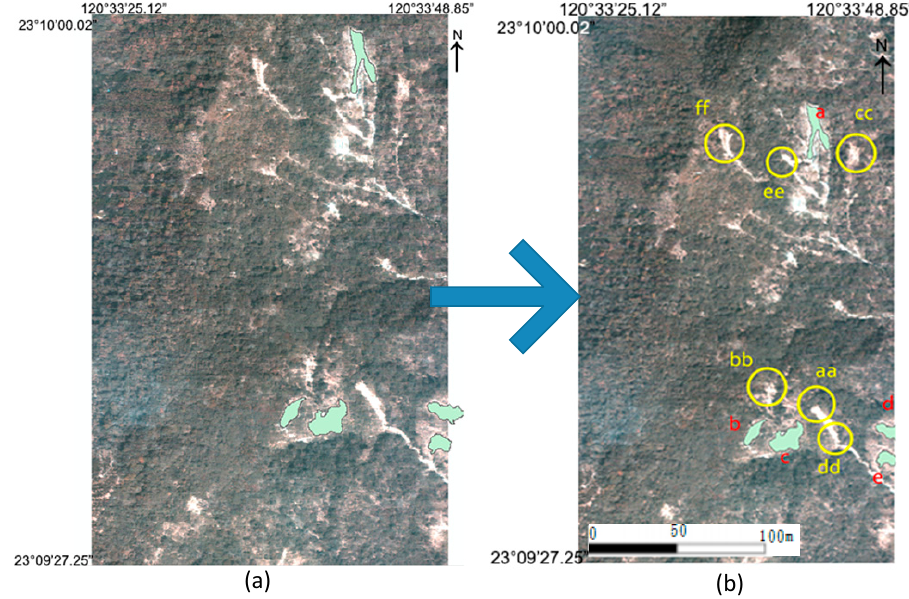
Figure 5. ( a ) original inventory map: landslide location of in situ investigation; ( b ) location of training sample, landslide: a, b, c, d, and e; bareland: aa, bb, cc, dd, ee, and ff.